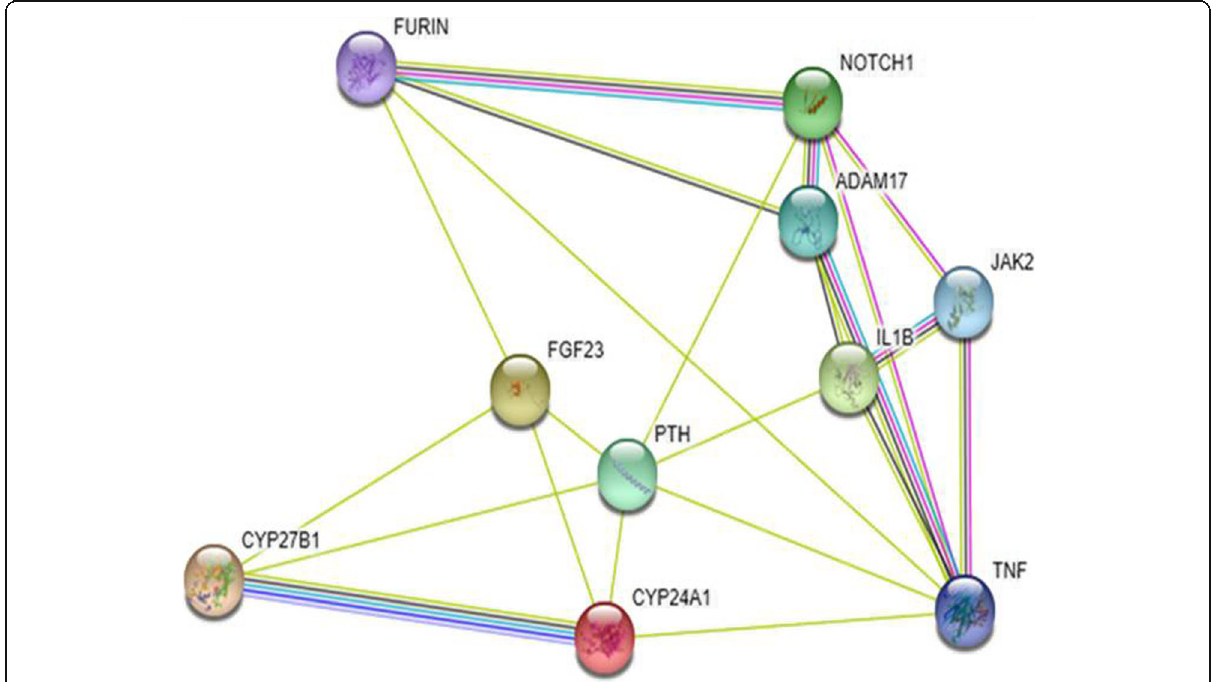
Fig. 7 The diagram shows the probable associations between various proteins (analysed using STRING software). The main nodes are formed by FGF23, CYP27B1, CYP24A1, PTH, FURIN, etc. The diagram indicates the importance of vitamin metabolism involving FGF23, CYP27B1, CYP24A1 and the regulation of Furin ultimately, which in turn is responsible for entry of coronavirus into the cell by interaction with